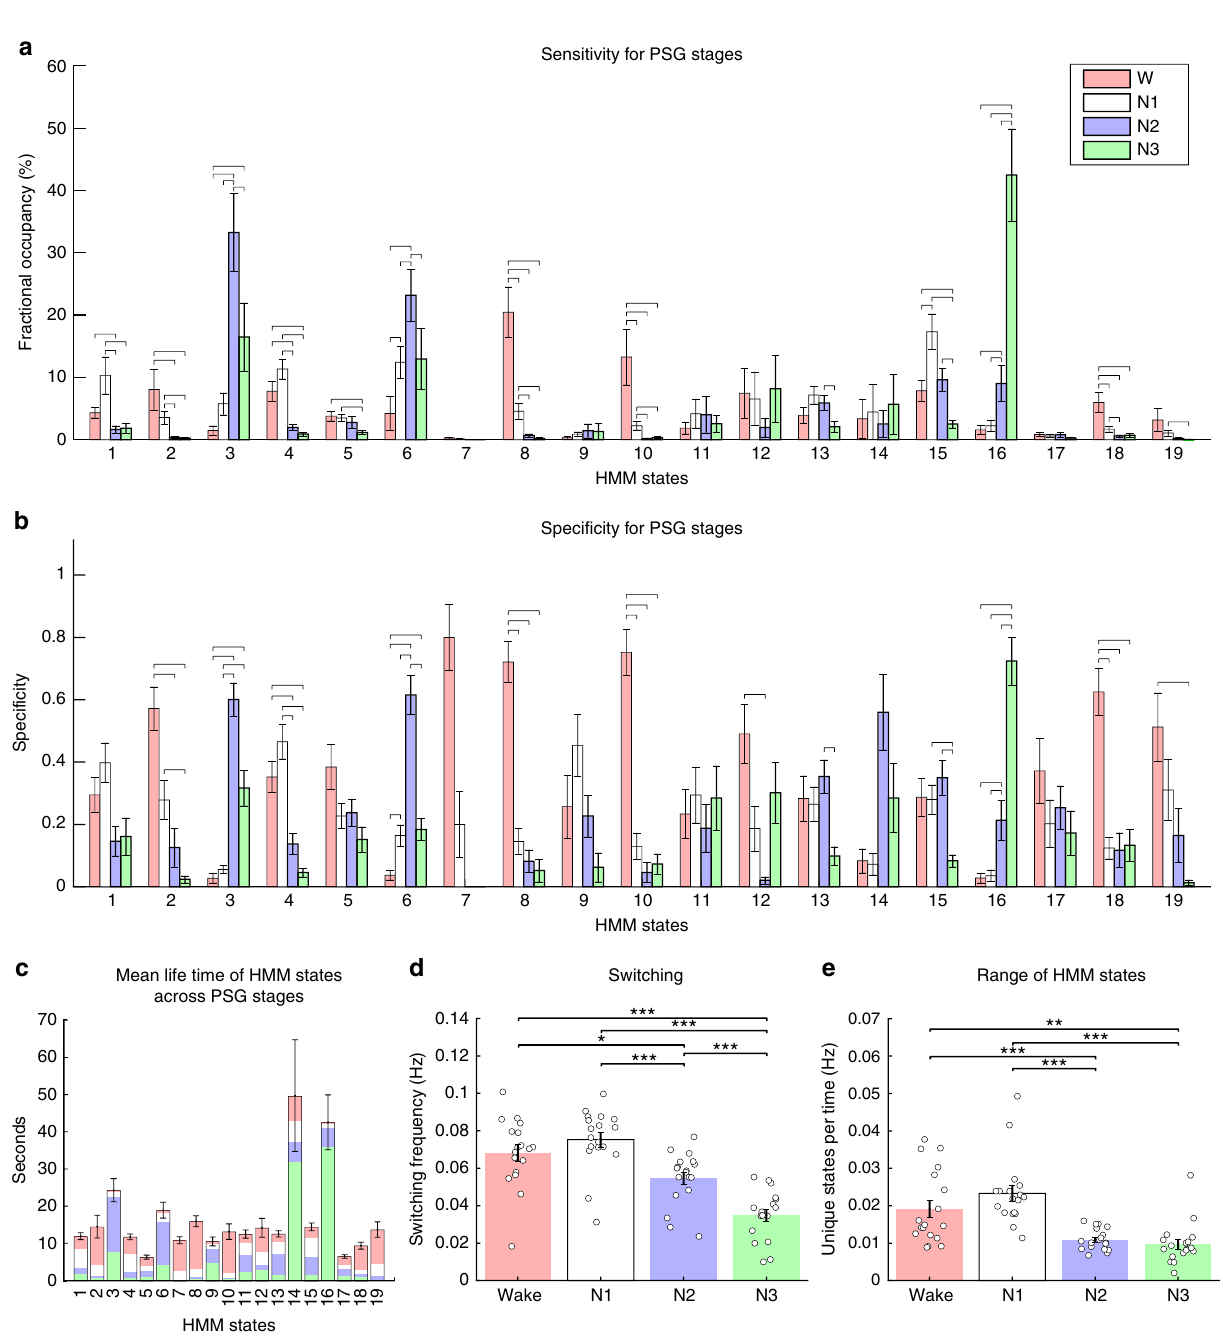
Fig. 3 Sensitivity and speci fi city of HMM states and dynamics within polysomnography stages. a Fractional occupancies of each of the 19 HMM states computed within the four PSG stages corresponded to the PSG-sensitivity of the whole-brain network states. The coloured bars and error bars show the average and standard error, respectively, across the 18 participants that included all four PSG stages. b PSG-speci fi city of the HMM states for each of the four PSG stages. Speci fi city corresponds to the probability of an HMM state occurring within a PSG stage. The bars represent the group average and the error bars the standard error ( n = 18). In a and b horizontal lines show signi fi cant differences within HMM states, with p values< 0.01 as evaluated through paired t tests and permutation testing. c The mean life times of the 19 HMM states are shown by the bars, representing values averaged across the 18 participants. Error-bars represent the standard error across participants. Each HMM state is coloured according to the probability of fi nding it within each of the four PSG stages, i.e., their PSG speci fi city. Note how HMM states with high speci fi city for N3 — and to a lesser extent N2 — exhibit longer mean life times. d The dynamics of the HMM transitions were calculated within each of the four PSG stages, in terms of switching frequency ( ‘ Switching ’ ), and e the number of different HMM states visited per time ( ‘ Range of HMM states ’ ). These measures signi fi cantly separate the four PSG stages suggestive of a higher dynamical repertoire during wakefulness and N1. In d and e error bars represent standard error across participants and signi fi cant differences between PSG stages are denoted by stars: one star: p < 0.05, two stars: p < 0.01 and three stars p < 0.001; all evaluated using paired t tests and permutations. W: wakefulness, N1: N1 sleep, N2: N2 sleep, N3: N3